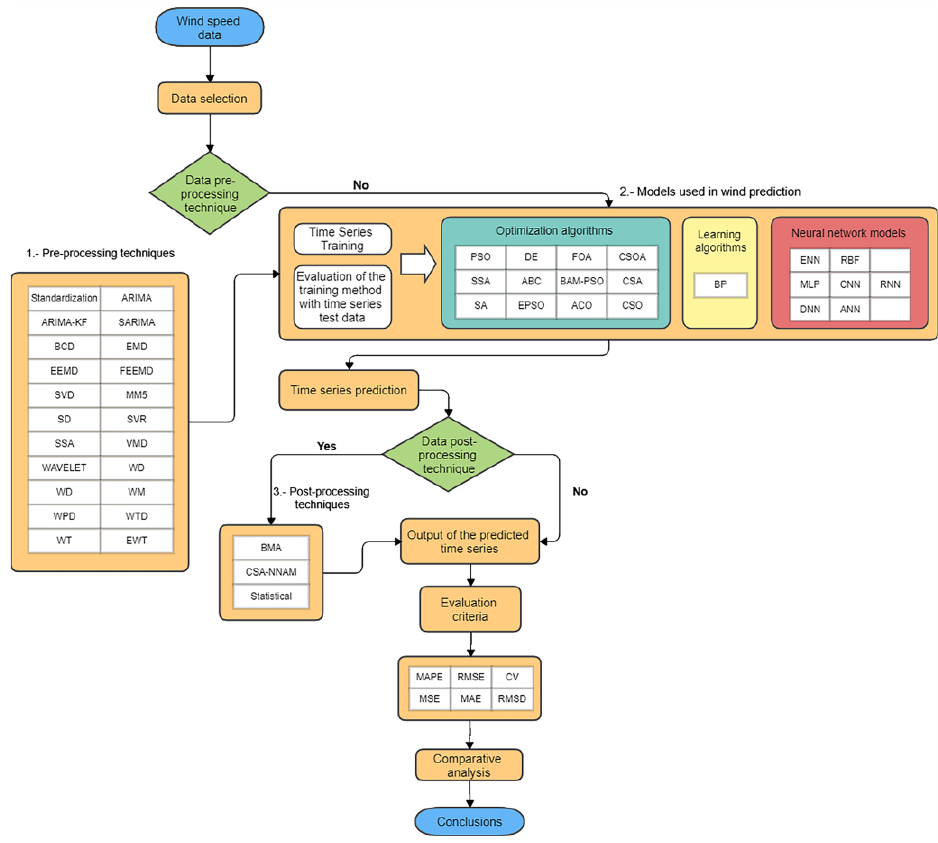
Figure 15. Diagram of the modeling process in wind prediction.